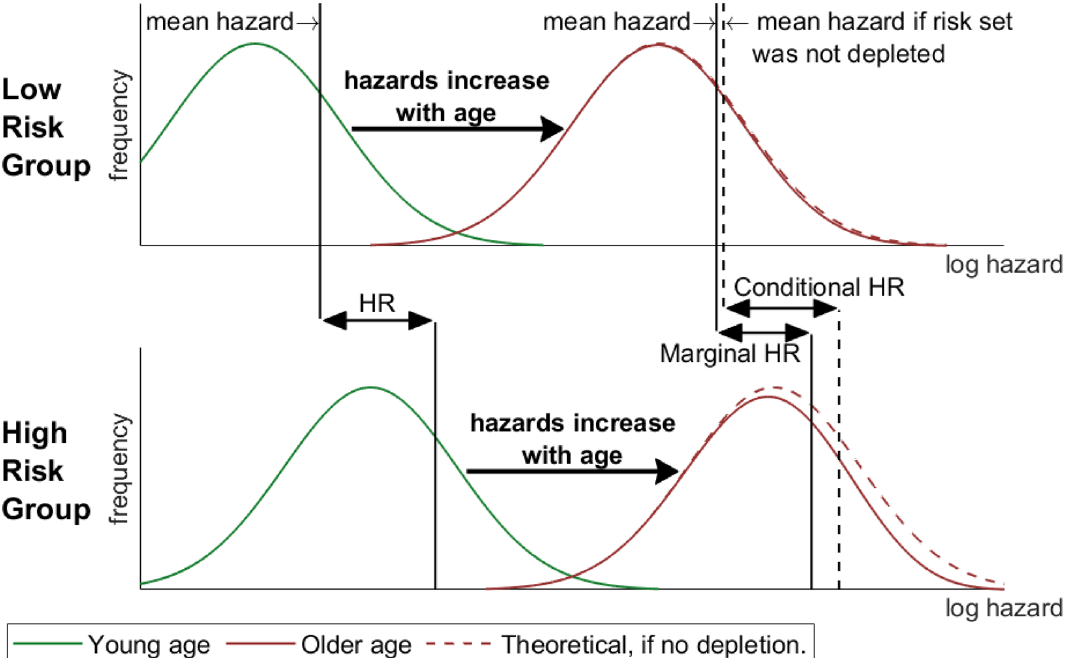
Figure 1. Unobserved heterogeneity attenuates hazard rates and ratios. The upper panel sketches the distribution of hazards within a low-risk group (e.g. non-smokers, normal blood pressure, normal cholesterol level,…). The green line refers to young, the red line to older age. The red dashed line shows the hypothetical distribution at older age if no CHD occurred: it is identical to the distribution at young age but shifted